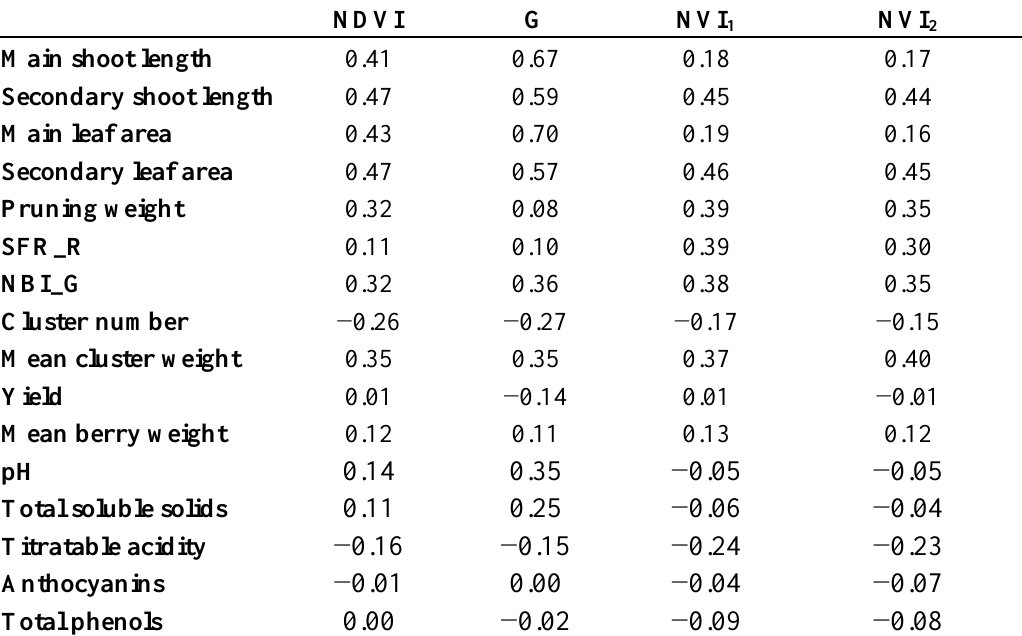
Table 4. Cross-tabulation outputs and kappa index obtained for the classified maps of spectral indices (NDVI, G, NVI 1 , and NVI 2 ), vegetative parameters (pruning weight, main shoot length, secondary shoot length, main leaf area per shoot, and secondary leaf area per shoot), fluorescence-based indices of nitrogen balance index (NBI_G AD ) and chlorophyll content in leaves (SFR_R AD ) for yield parameters (cluster number per vine, cluster weight, yield per vine, and berry weight) and for grape composition variables (pH, total soluble solids, titratable acidity, anthocyanins, and total phenols) in a Tempranillo ( Vitis vinifera L.)